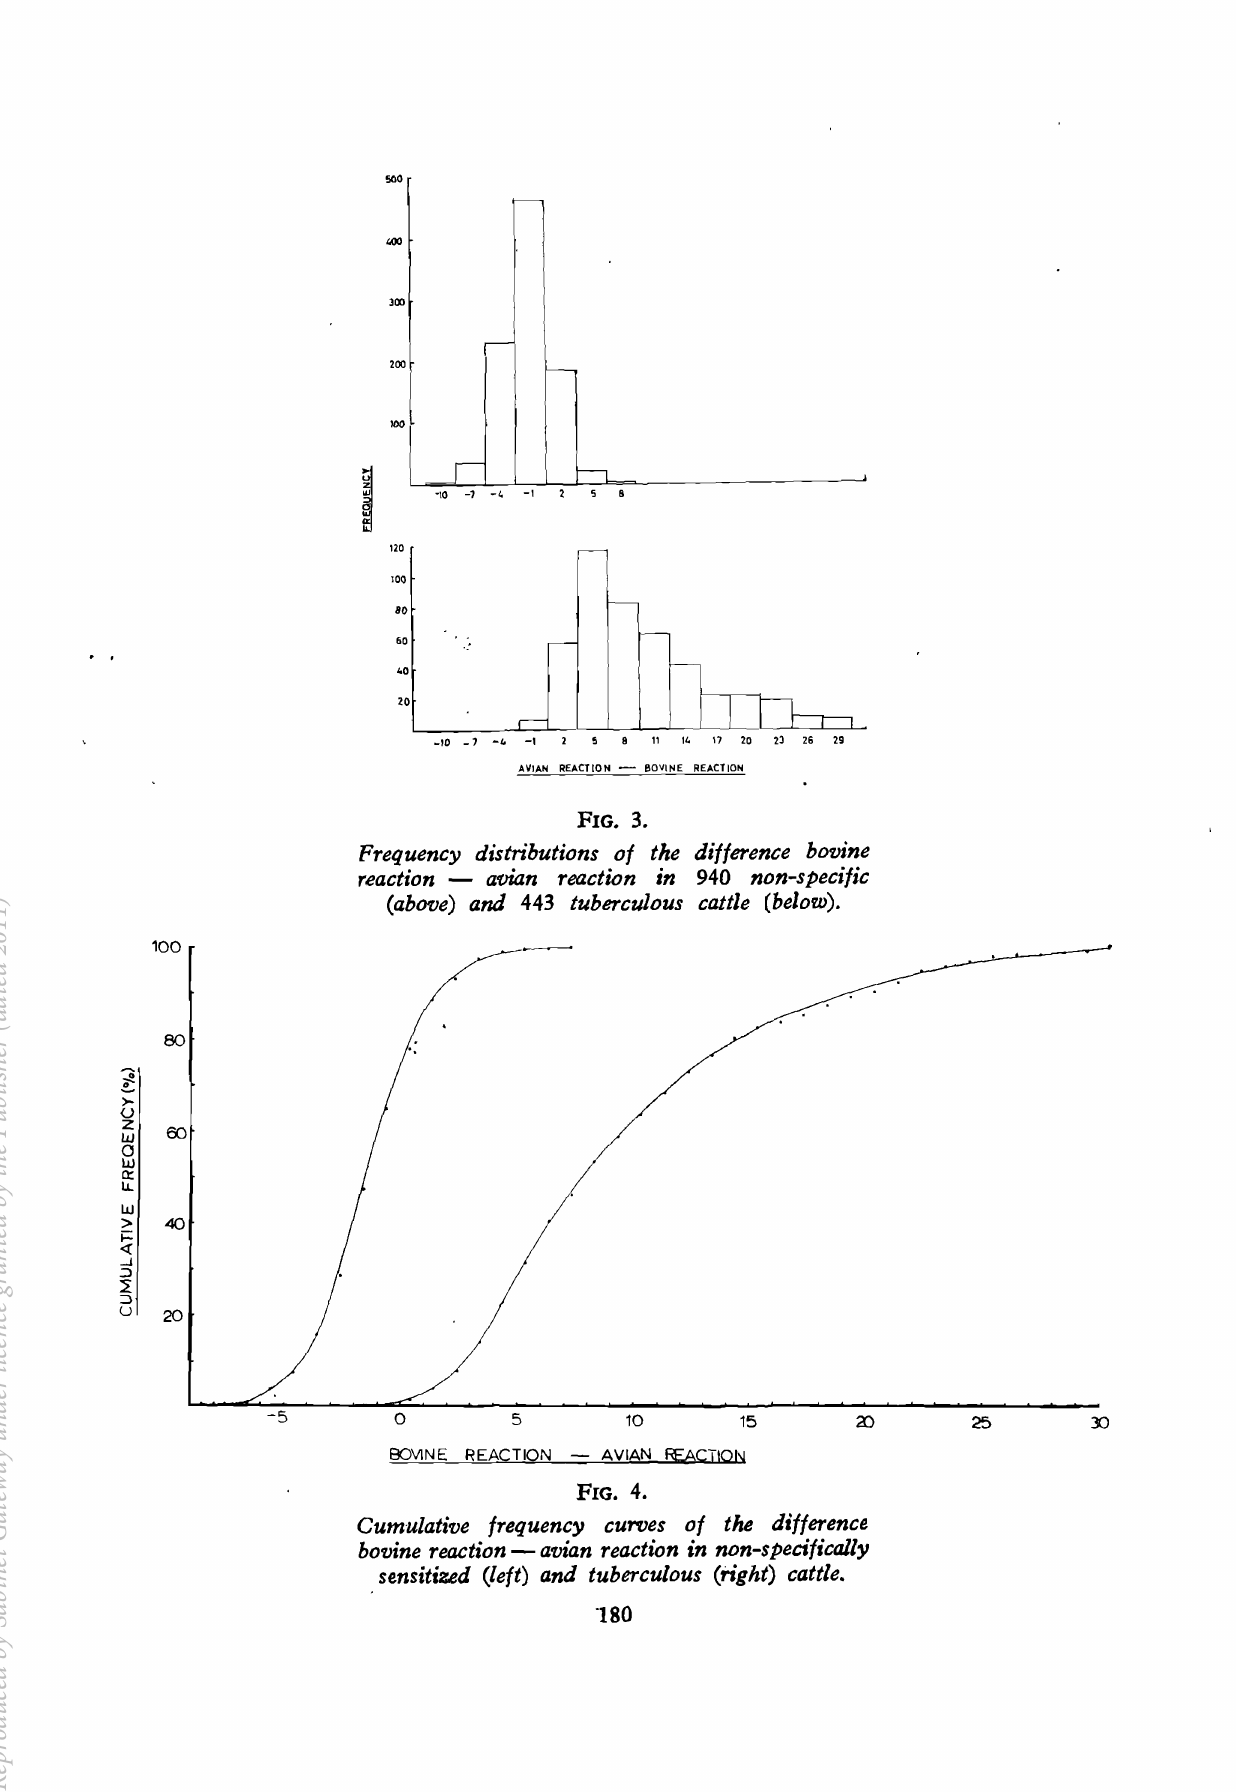
Cumulative frequency curves of the difference bovine reaction - avian reaction in non-specifically sensitiud (left) and tuberculous (right) cattle. 180